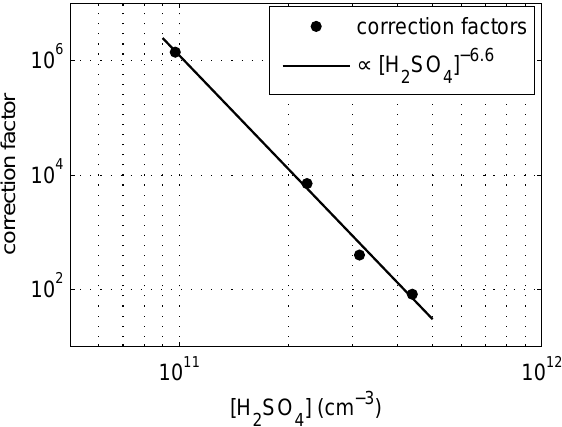
Figure 1. Correction factors for nucleation rate obtained from CNT as a function of raw exhaust sulfuric acid vapor concentration. Fig- ure adapted from Olin et al.